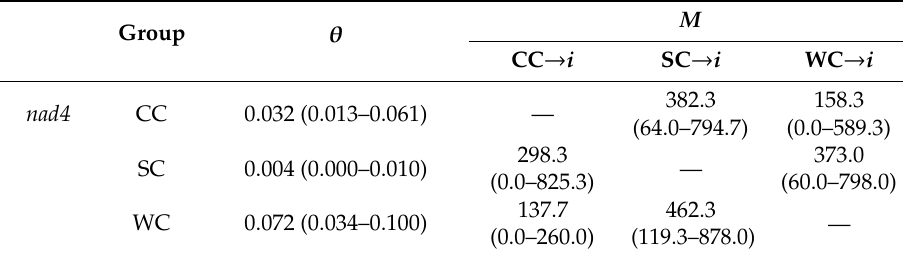
Table 5. Estimates of gene flow among three groups of Bactrocera minax populations.